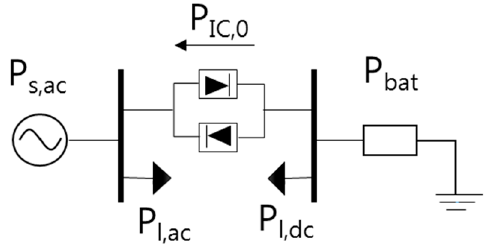
Figure 10. IC initial active power flow.